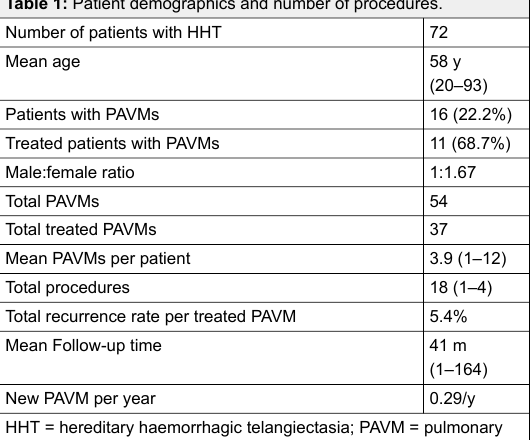
Table 1: Patient demographics and number of procedures.